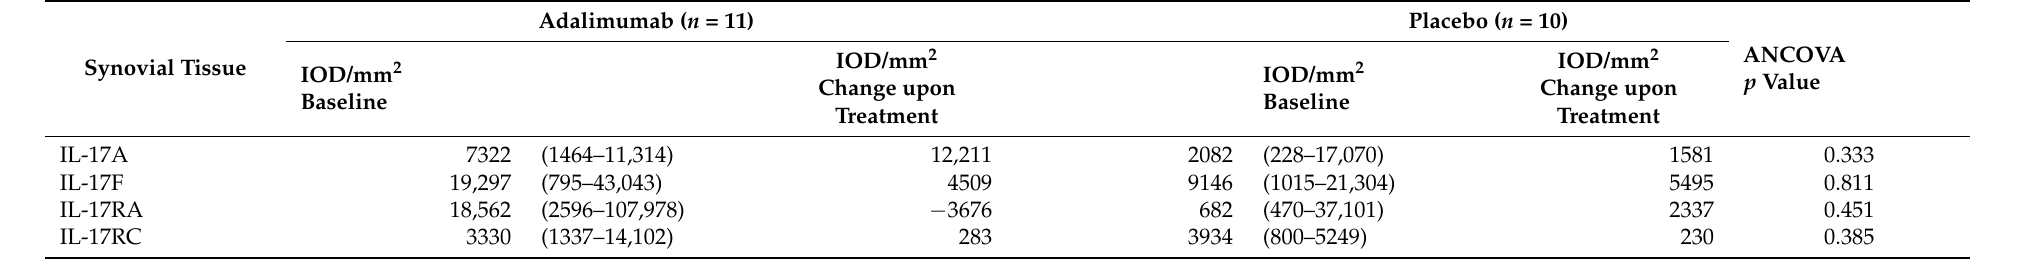
Table 3. Median IOD/mm 2 values of IL-17 expression in synovial tissue before and after treatment with adalimumab compared to